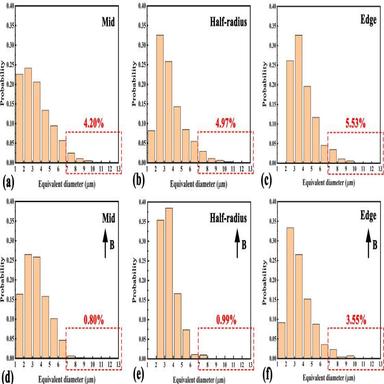
Statistics results on the probability of inclusions (different size) in different regions of LMF (with or without ASMF) in this study, (a) Mid region without ASMF, (b) Half-radius region without ASMF, (c) Edge region without ASMF, (d) Mid region with ASMF, (e) Half-radius region with ASMF, (f) Edge region with ASMF, respectively.